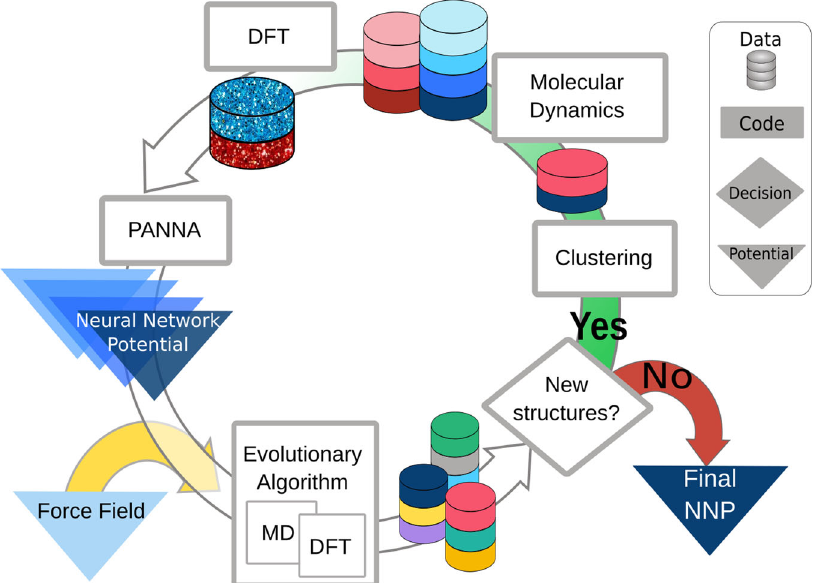
Fig. 1 The self-consistent scheme. The initial step to start the process (yellow arrow) can be performed with a classical force fi eld as shown here, or any comprehensive dataset of structures such as the ones in A fl owlib 72 , Materials Genome Initiative 73 , or Nomad 74 repositories can be used to generate the fi rst neural network potential model (blue triangle) to be re fi ned through the self-consistent cycle. Once an initial potential model is chosen, evolutionary algorithm enables a diverse set of structures to be sampled. The following clustering-based pruning of structures further ensures that no single polymorph biases the dataset, i.e., at each step only novel structures (red and blue disks for the particular step highlighted above) are to be considered, further re fi ned, and added to the dataset. The subsequent MD simulations sample the potential energy surface of each polymorph. Finally, DFT calculations performed on a subset of MD-sampled structures are added to the ab initio dataset obtained thus far. The ab initio dataset augmented this way is then used to train the next neural network potential model (a darker blue triangle), starting the next cycle of the self-consistent scheme until no new structures are found by the evolutionary